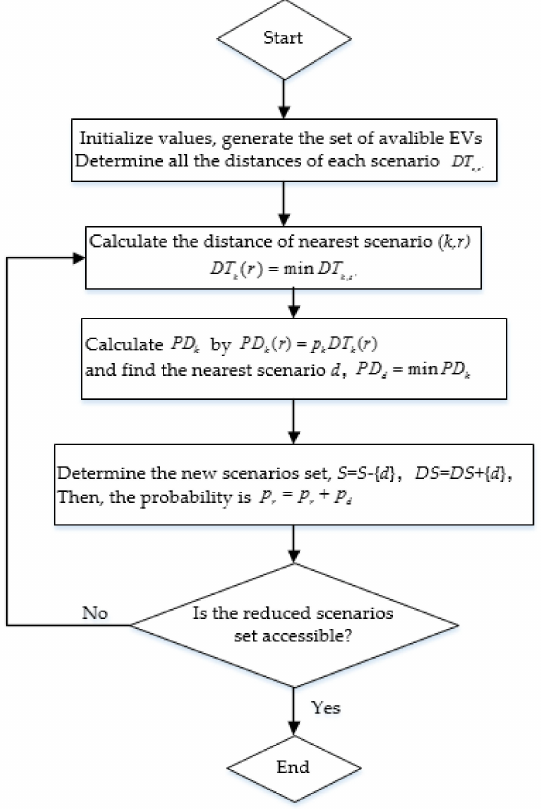
Figure 5. The flow chart of scenario